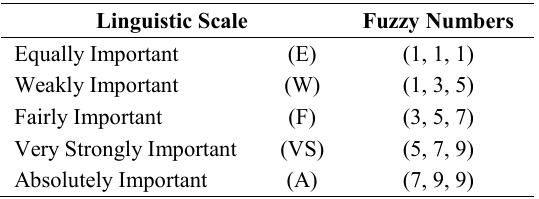
Table 1. Linguistic variables for comparison of two criteria.